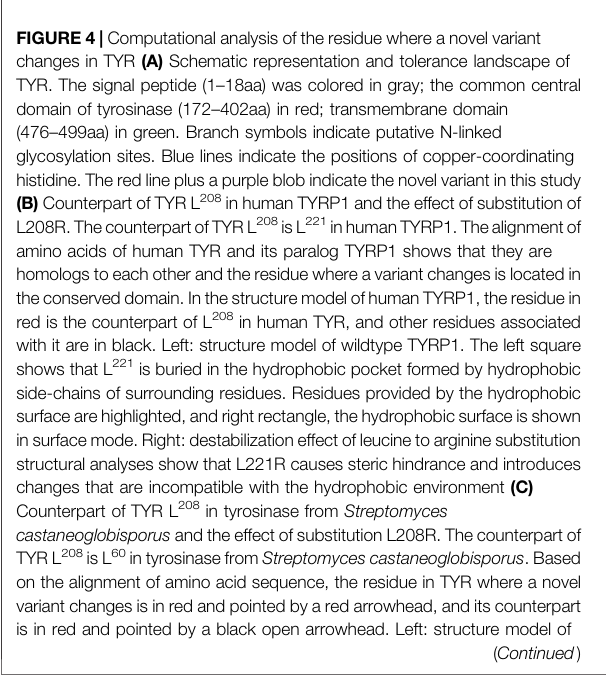
FIGURE 4 | wildtype tyrosinase from Streptomyces castaneoglobisporus . The left square shows that L 60 is buried in the hydrophobic pocket formed by hydrophobic side-chains of surrounding residues. Residues providing the hydrophobic surface are highlighted, and right rectangle, the hydrophobic surface is shown in surface mode. Right: destabilization effect of the sub- stitution of leucine to arginine structural analyses show that L60R cause steric hindrance and introduces charges that are incompatible with a hydrophobic